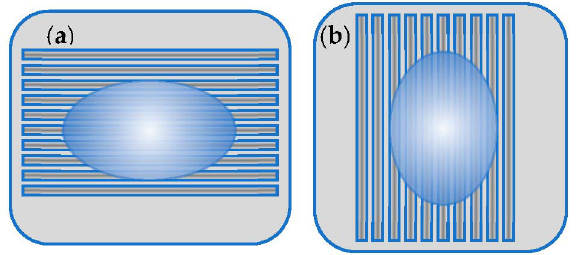
Figure 8. Scheme of water droplet positioning of Fs modified PLA samples: ( a ) perpendicular to the laser created grooves and ( b ) along the laser created grooves.